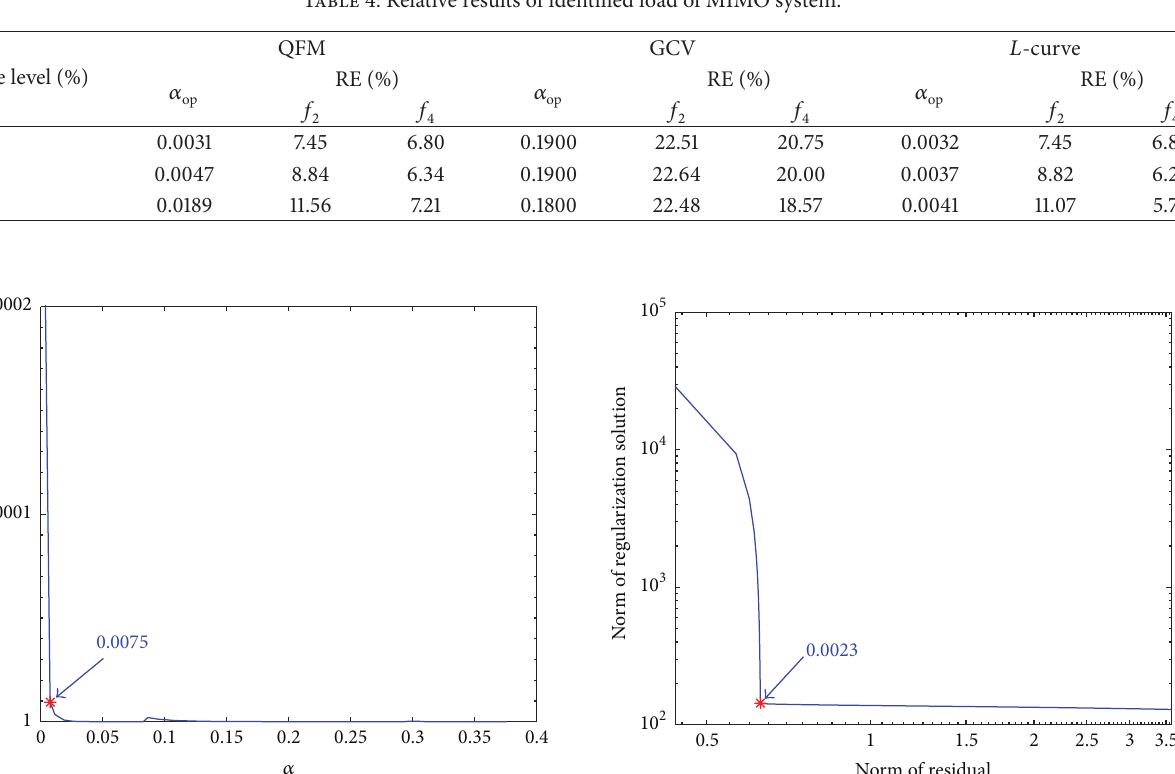
Table 4: Relative results of identified load of MIMO system.